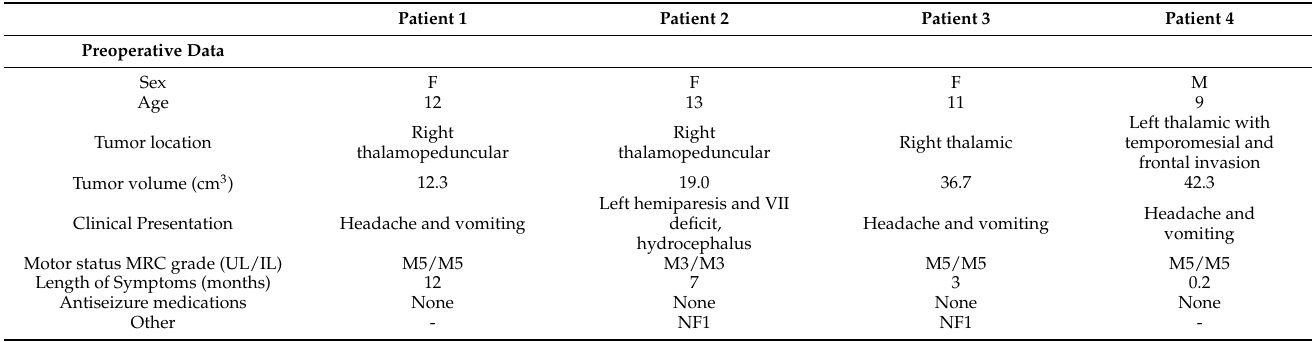
Table 1. Preoperative data.